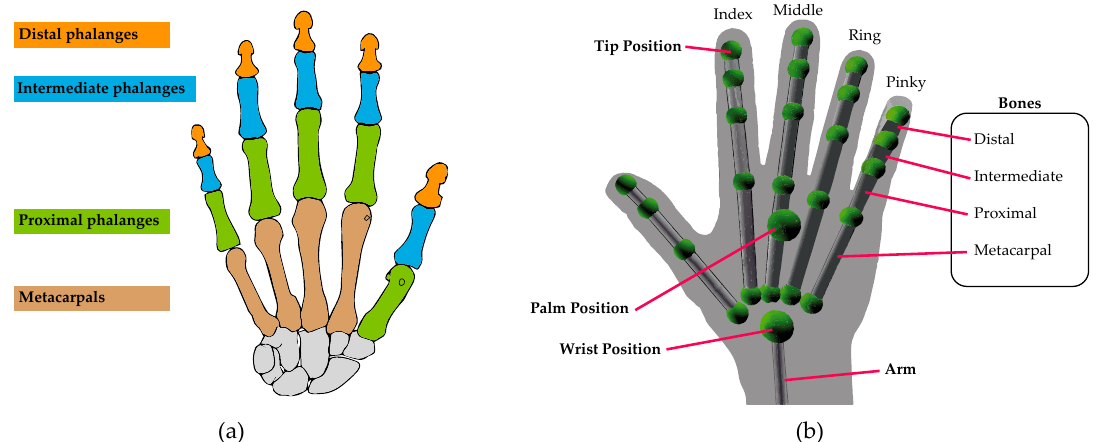
Figure 12. Tracking of the hands skeletal model ( a ) Object Bone. ( b ) Object Hand. Sensor 2020 , 22 , x FOR PEER REVIEW